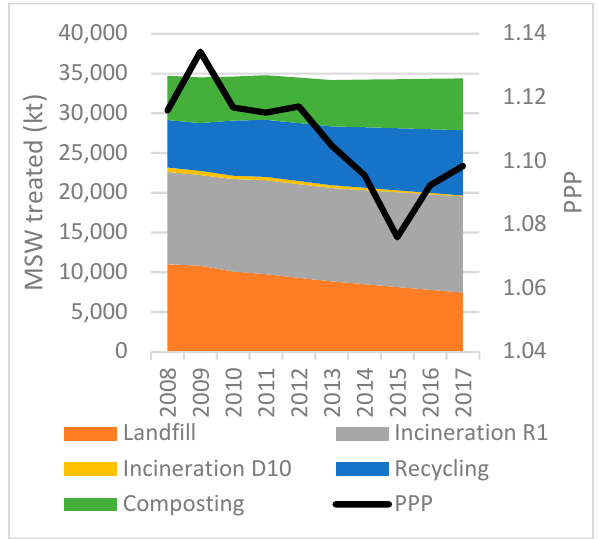
Figure 20. Waste treatment methods and PPP in France 2008–2017 (EUROSTAT 2019b, 2019c).